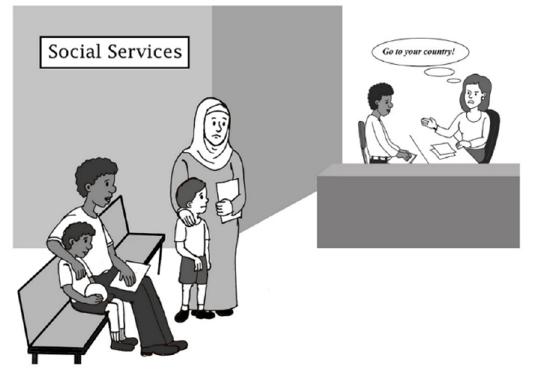
Figure 2. Scenario 8 of the PEI.